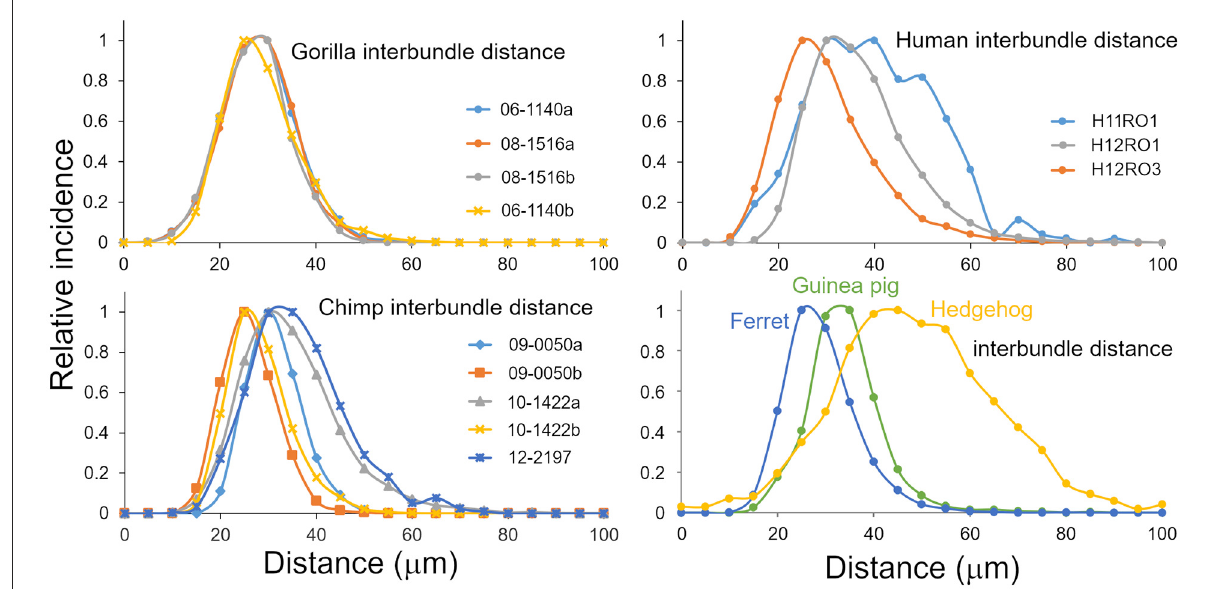
FIGURE3 Distribution of inter-bundle distances measured in orthogonal sections from six species where there was a regular arrangement of fibers into bundles. Each plotted line is based on multiple sections from a different block as indicated by the legend.